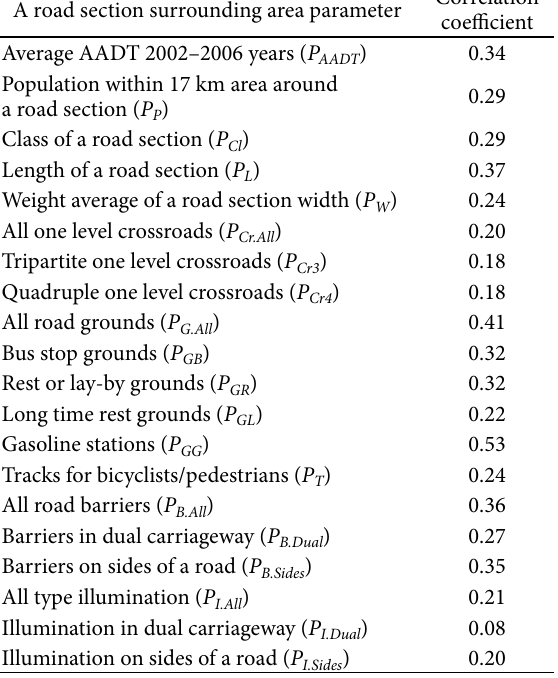
Table 6. The correlation coefficient between traffic accidents in a road section in Lithuanian main and interurban road networks and the described road section parameters in the years 2002–2006 A road section surrounding area parameter